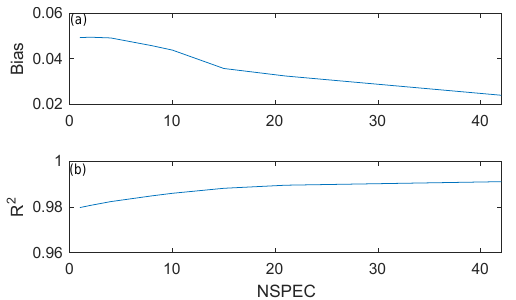
Figure 7. (a) Normalized bias (sum minus total, normalized by the total) and (b) coefficient of determination between total variance sonic versus the sum of low-passed and high-passed variances from sonic anemometers with the timescale determined by the 449MHz WPR under differing numbers of spectral averages (NSPEC). Data from all six heights and all dates of sonic anemome- ter measurements are included.